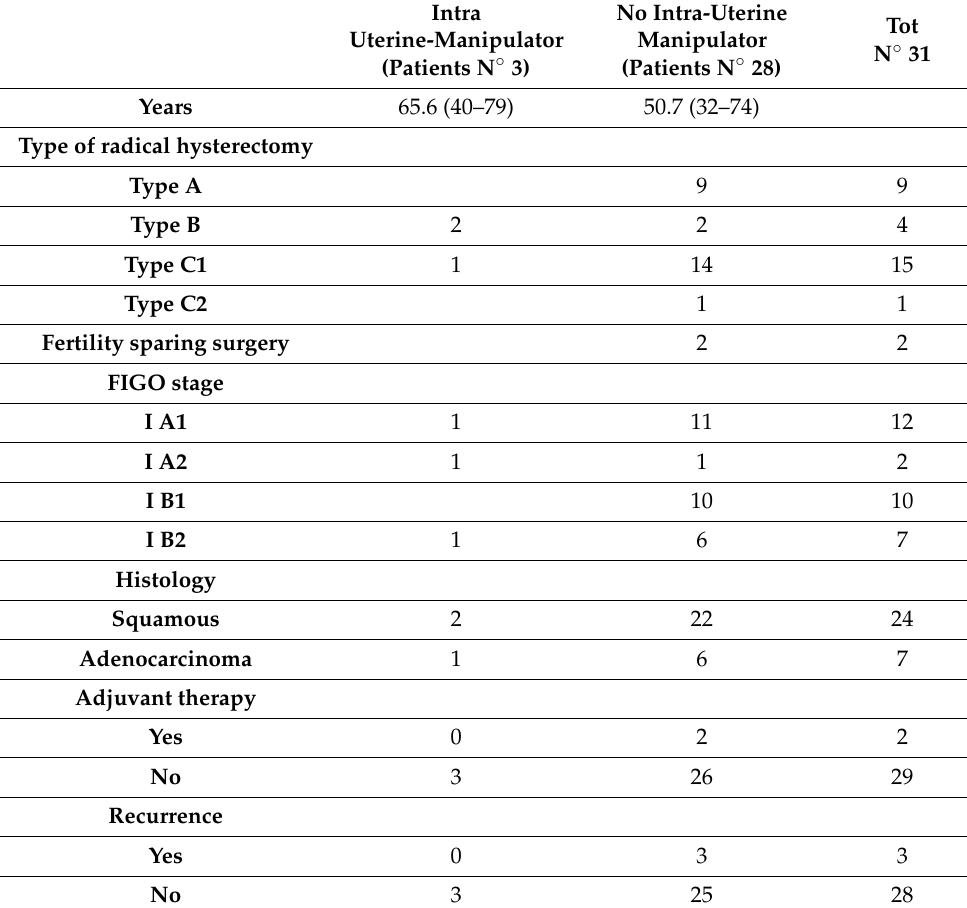
Table 2. Patients and tumor